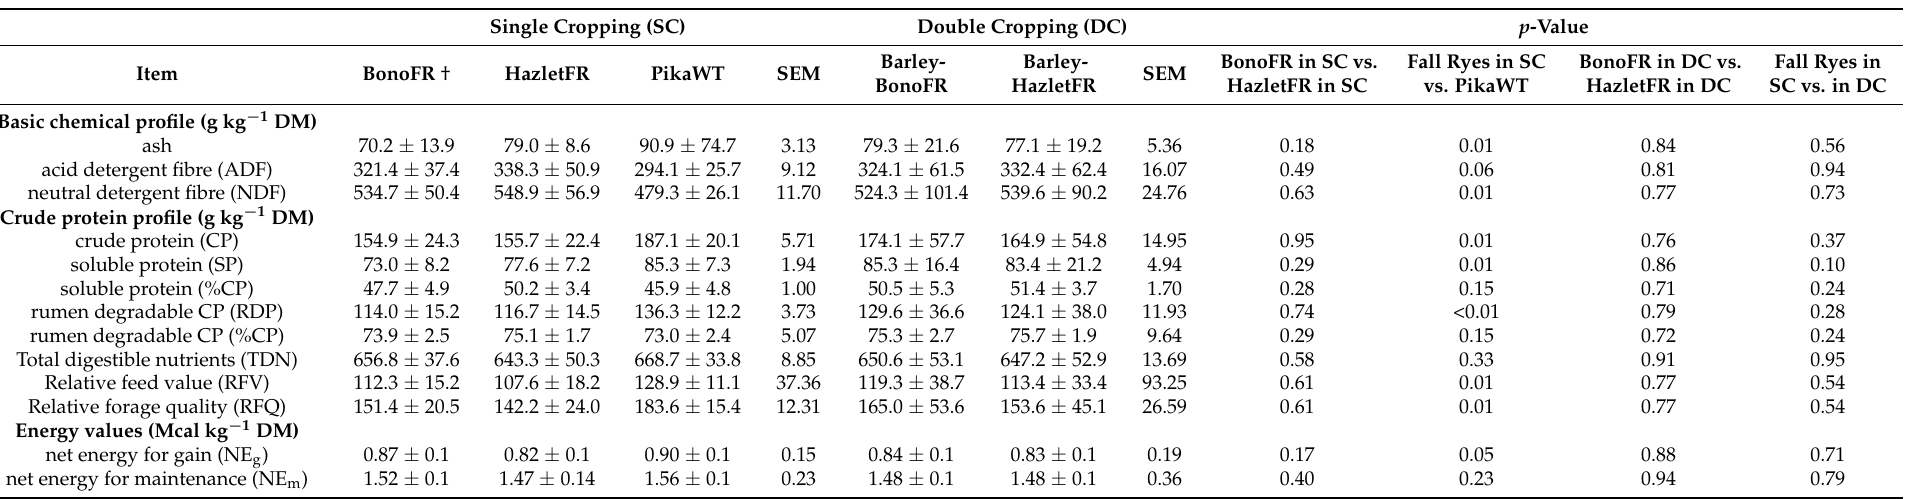
Table 5. Nutrient composition (means ± SD) of whole-crop winter cereals in single and double cropping systems. Single Cropping (SC) Double Cropping (DC) p -Value